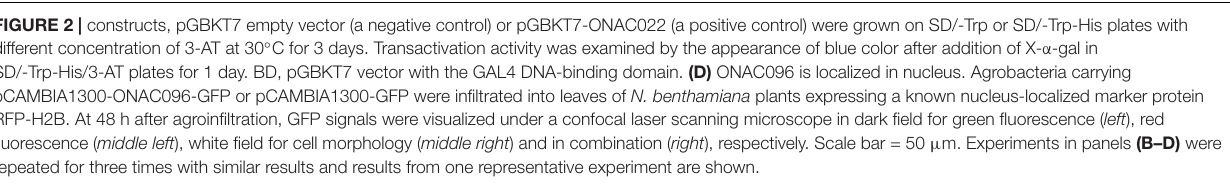
FIGURE 2 | constructs, pGBKT7 empty vector (a negative control) or pGBKT7-ONAC022 (a positive control) were grown on SD/-Trp or SD/-Trp-His plates with different concentration of 3-AT at 30 ◦ C for 3 days. Transactivation activity was examined by the appearance of blue color after addition of X- α -gal in SD/-Trp-His/3-AT plates for 1 day. BD, pGBKT7 vector with the GAL4 DNA-binding domain. (D) ONAC096 is localized in nucleus. Agrobacteria carrying pCAMBIA1300-ONAC096-GFP or pCAMBIA1300-GFP were infiltrated into leaves of N. benthamiana plants expressing a known nucleus-localized marker protein RFP-H2B. At 48 h after agroinfiltration, GFP signals were visualized under a confocal laser scanning microscope in dark field for green fluorescence ( left ), red fluorescence ( middle left ), white field for cell morphology ( middle right ) and in combination ( right ), respectively. Scale bar = 50 µ m. Experiments in panels (B–D) were repeated for three times with similar results and results from one representative experiment are